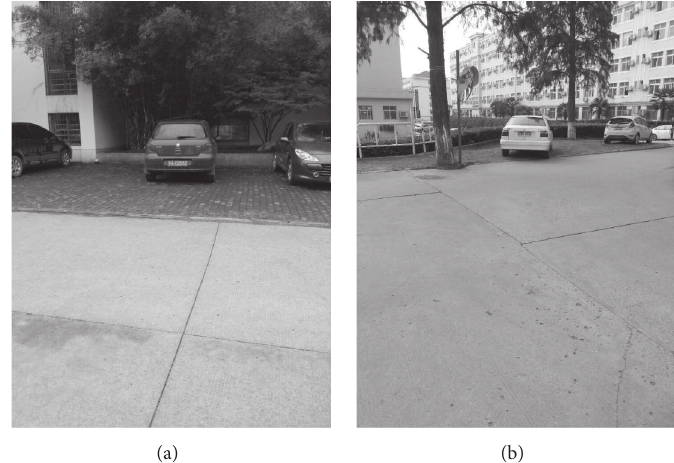
Figure 13: One of the LR plate images in the case of long distance. (a) Vehicle sequence I and (b) vehicle sequence II.